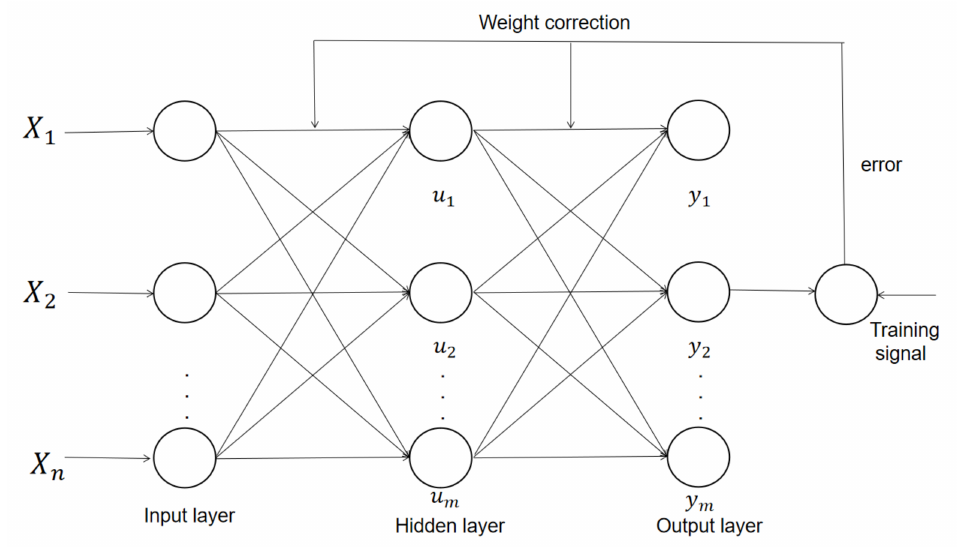
Figure 3. Three-layer BP artificial neural